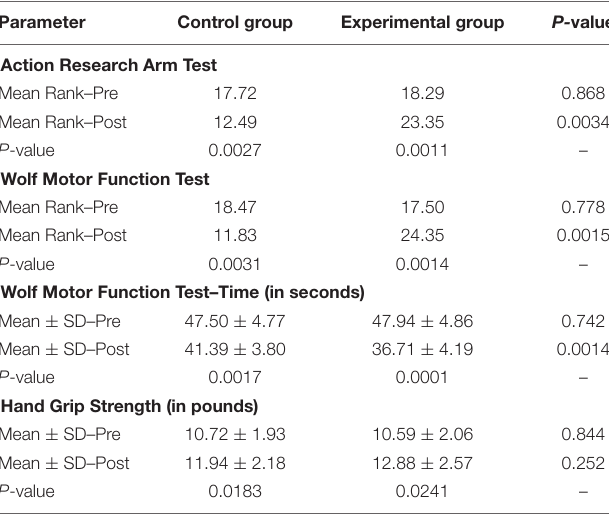
TABLE 2 | Within- and between- group differences for upper-limb functional measures at baseline and immediately after 12 weeks of